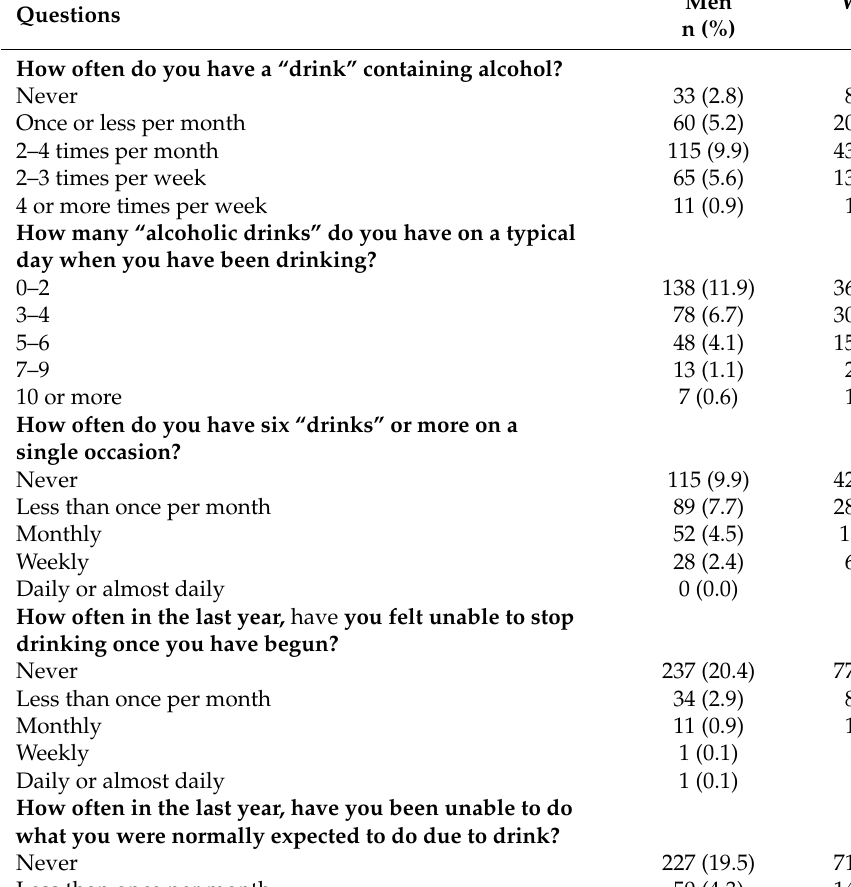
Table 2. Distribution of answers to the AUDIT *